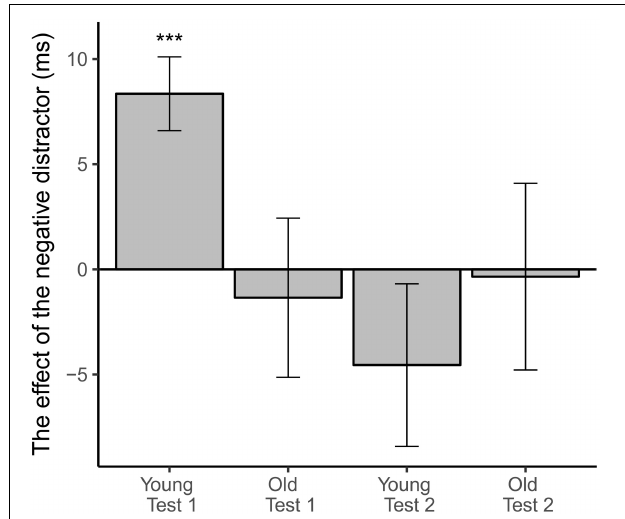
FIGURE 4 | The average reaction times per block in the first and in the second test. When only the last four blocks were compared, there was no significant difference in reaction times. The curve of the first test has a decreasing trend but in the second testing session reaction times remained stable throughout the test.